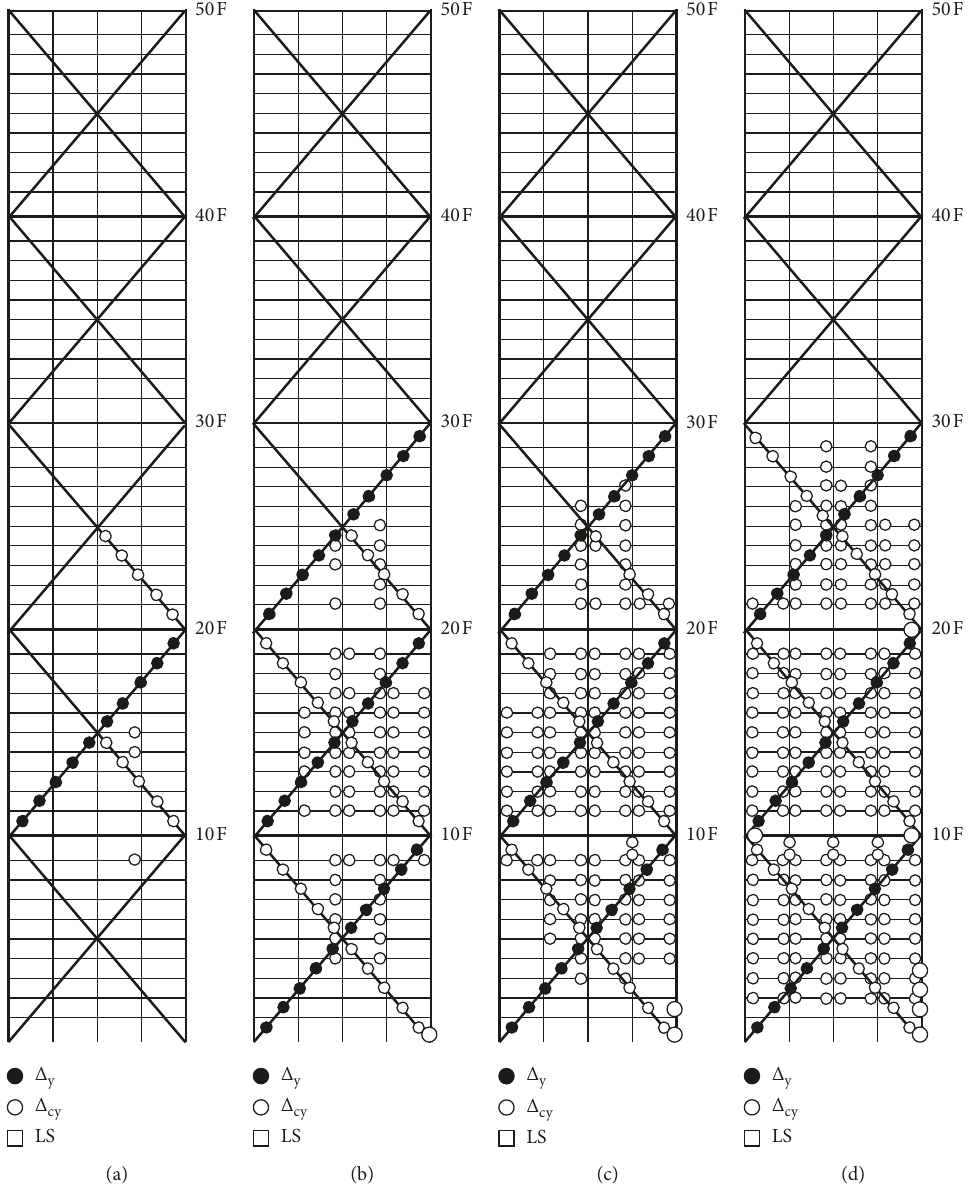
Figure 9: Plastic hinge formation in the web-side frame of model 5MXBC: (a) first yield ( δ (c) secondary column yield ( δ